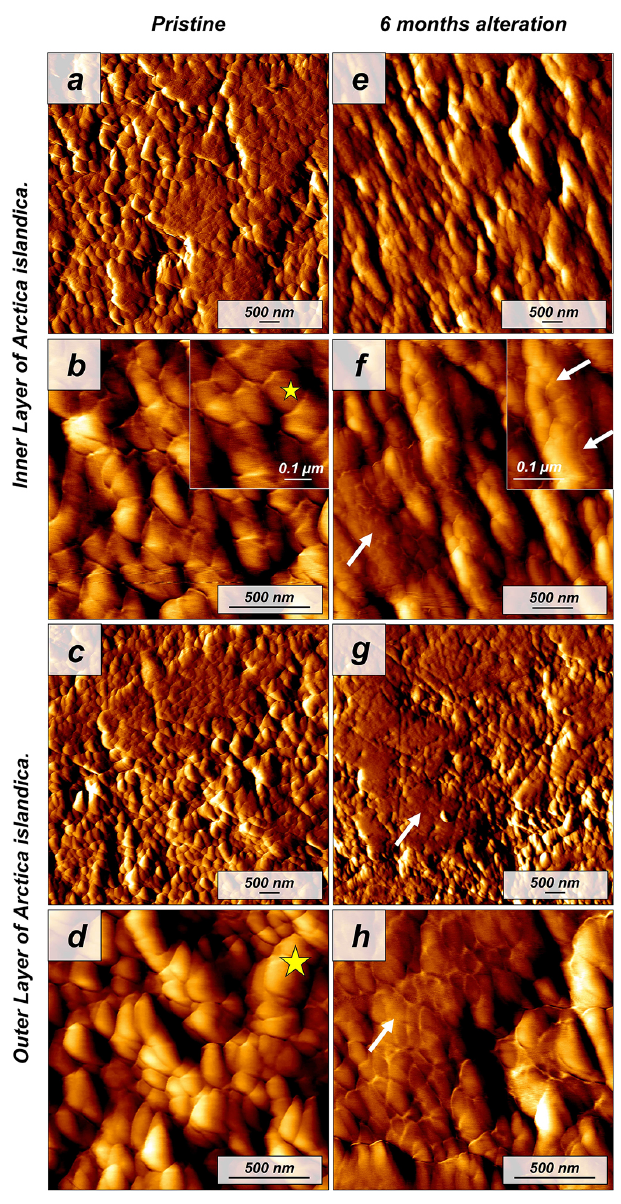
Figure 2. Vertical deflection AFM images of (a–d) pristine and (e– h) altered shells of the bivalve Arctica islandica . Pristine shells of Arctica islandica are composed of two aragonitic layers formed by aragonitic subunits of less than 100nm in size (yellow star in pan- els b and d ; shell constituent units). Insets in panels (b) and (f) show a closer view of these units. Hydrothermal alteration induces amal- gamation of the subunits (white arrows in panels e–h